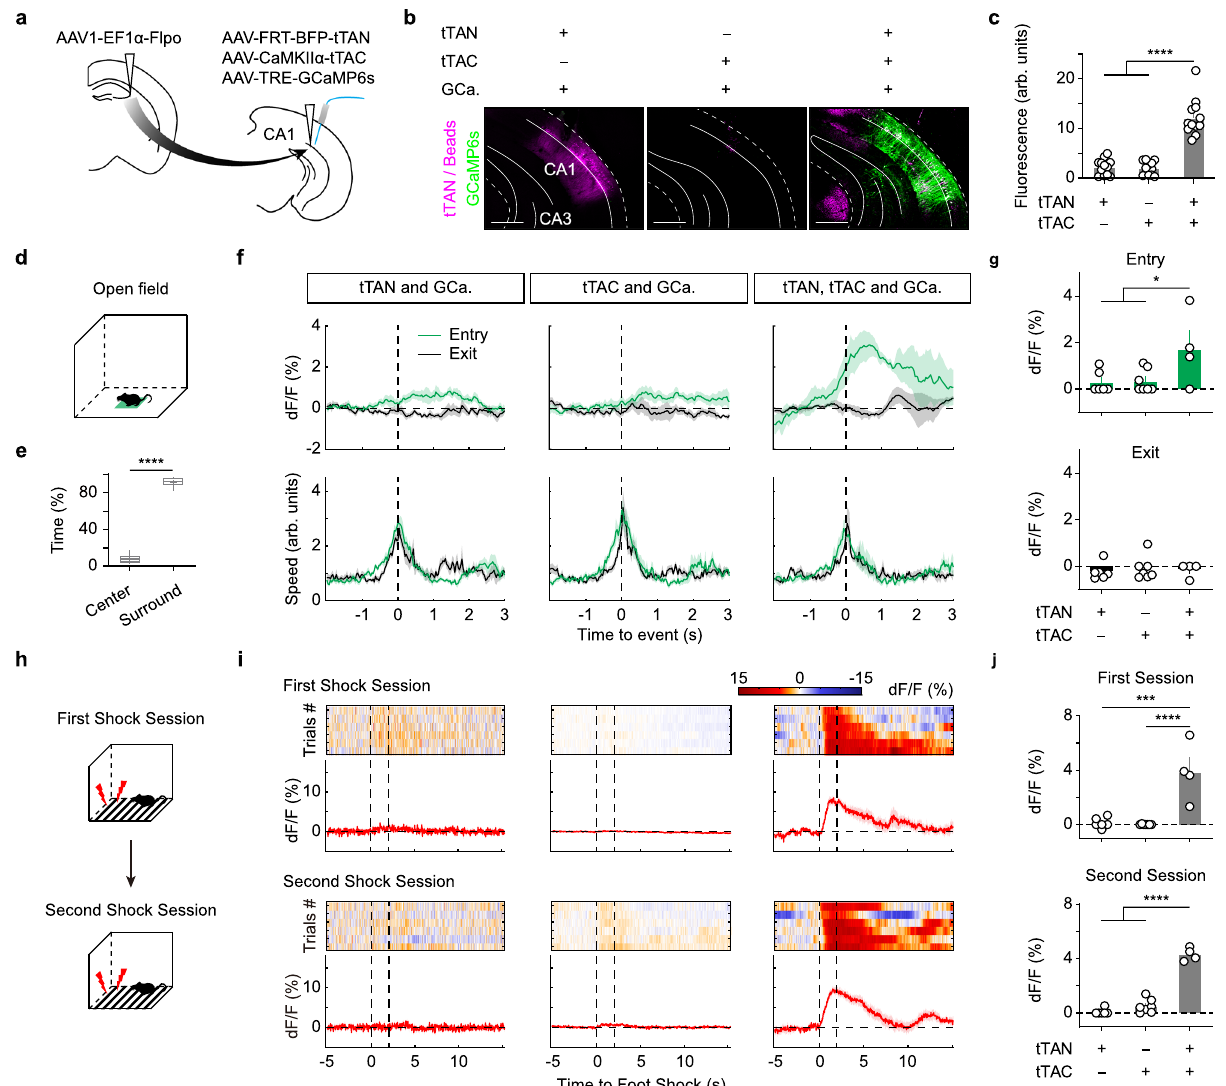
Fig. 4 The IBIST-based Ca 2 + recording for cells de fi ned by genetic marker and neural connectivity. a Scheme illustrating AAV injections to de fi ne cells by two features: anterograde transsynaptic tracing and CaMKII α -speci fi c fl uorophore labeling. b Examples showing fl uorescence of the ventral hippocampus infected by AAVs of Flpo, tTAN (magenta), tTAC and TRE-GCaMP6s (GCa., green) and co-injected with blue beads (magenta). Scale bars: 500 µ m. c , Summary of fl uorescent intensity of GCaMP6s in b . One-way ANOVA between groups: F (2,33) = 66.19, **** P = 2.82 × 10 − 12 . Turkey ’ s multiple comparisons: tTAN vs. tTAN + tTAC, **** P = 4.91 × 10 − 11 ; tTAC vs. tTAN + tTAC, **** P = 3.88 × 10 − 11 . N = 3 animals/group. d Scheme illustrating the open fi eld test. e Box plot of the percentage time in the center zone and surround. Center vs. surround, 8.2 ± 1.0% vs. 91.8 ± 1.0%, paired t -test, **** P = 2.08 × 10 − 18 ; N = 17 animals. f Examples of averaged traces of Ca 2 + signals and animal speeds upon center entry (green) and exit (black) in the open fi eld test. g Summary of normalized Ca 2 + responses upon center entry and exit. One-way ANOVA between groups (tTAN, 0.3 ± 0.2%, N = 6 animals; tTAC, 0.4 ± 0.2%, N = 7 animals; tTAN + tTAC, 1.7 ± 0.8%, N = 4 animals; F (2,14) = 4.275, * P = 0.0356; Turkey ’ s multiple comparisons, * P < 0.05). h Scheme illustrating the foot shock test. i Examples of heatmaps and averaged traces of Ca 2 + signals upon foot shocks (between dash lines,). j , Summary of Ca 2 + responses. One-way ANOVA between groups in fi rst session (tTAN, 0.1 ± 0.2%, N = 6 animals; tTAC, 0.01 ± 0.01%, N = 7 animals; tTAN + tTAC, 3.9 ± 1.1%, N = 4 animals; F (2,14) = 21.17, **** P = 5.7 × 10 − 5 ; Turkey ’ s multiple comparisons, *** P < 0.001) and second session (tTAN, 0.1 ± 0.1%, N = 6 animals; tTAC, 0.5 ± 0.2%, N = 7 animals; tTAN + tTAC, 4.3 ± 0.2%, N = 4 animals; F (2,14) = 141.3, **** P = 5.23 × 10 − 10 ; Turkey ’ s multiple comparisons, *** *P < 0.0001). Data summary: mean ± SEM. Statistical analysis: two sided. Box plots: whiskers (min/max), middle line (median), plus (mean), box (25/ 75 percentile). Source data are provided as a Source Data fi